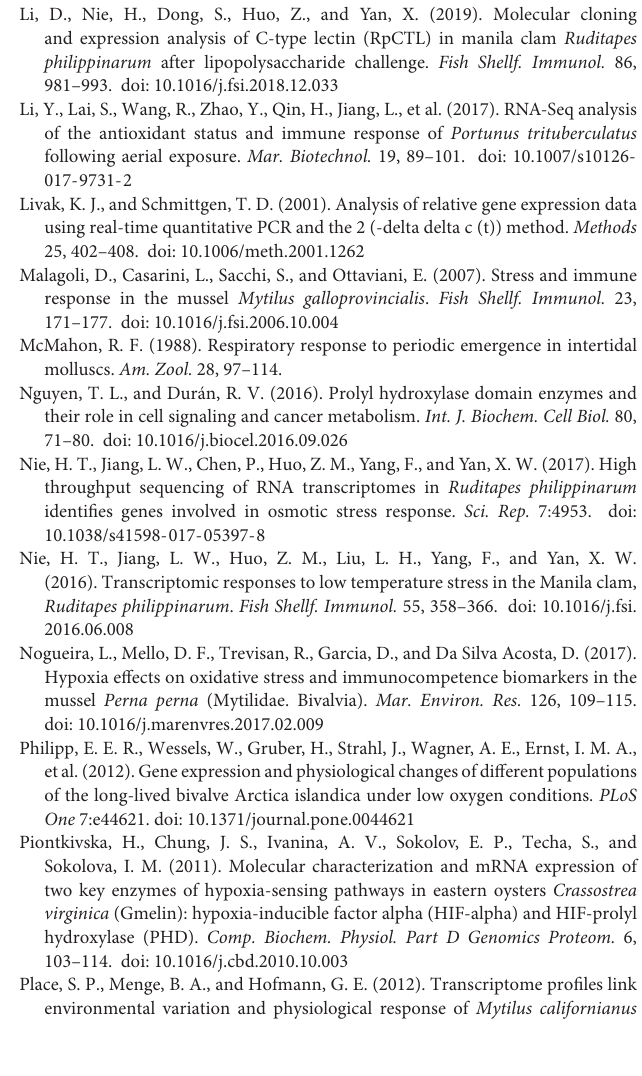
FIGURE S1 | The quality of the total RNA used in this study. TABLE S1 | The primers used in this